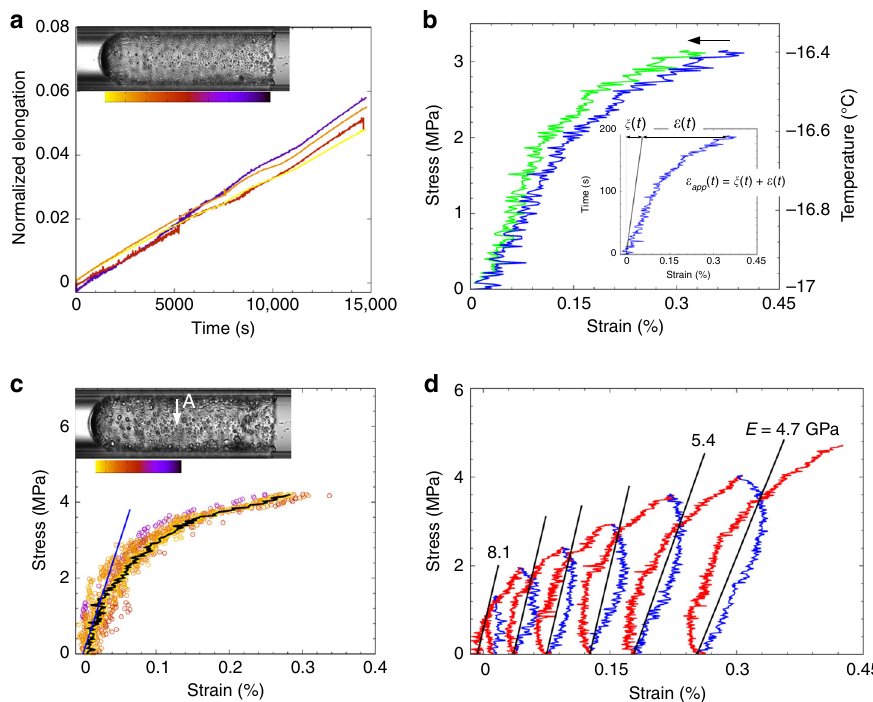
Fig. 2 Axial stress vs . axial strain. a Homogeneous crystal growth down the length of the sleeve during annealing, shown by the collapse to a common master curve, of the normalized deformation, ξ ( t ) (Eq. (6)) at four locations with positions colour coded by the inset; b Application of a temperature ramp after annealing stresses the hydrate sleeve. Inset: correction of the apparent strain ϵ app ( t ) (blue) for continuing crystal growth ξ ( t ) to yield the stress- induced strain, ϵ ( t ) (green) ; c Stress – strain data for 13 sample points down the length of the sleeve (colour code in the inset), illustrate the homogeneous strain fi eld under monotonic loading up to failure. Black curve : for point A in the inset; blue line : elastic modulus 5.9 GPa; d A cyclic tensile test shows plastic deformation, with increasing residual strains, and fatigue: the elastic modulus determined according to ref. 54 , decreases with successive cycles. Data are for t a = 7 h in b – d and for Δ T = 40.3 K except ( b ), Δ T = 33.8 K. Axial loading/unloading rates in d ≈ 4.5 MPa/min (0.5 K/min, red branches), resp. ≈ − 8.9 MPa/min ( − 1.0 K/min,